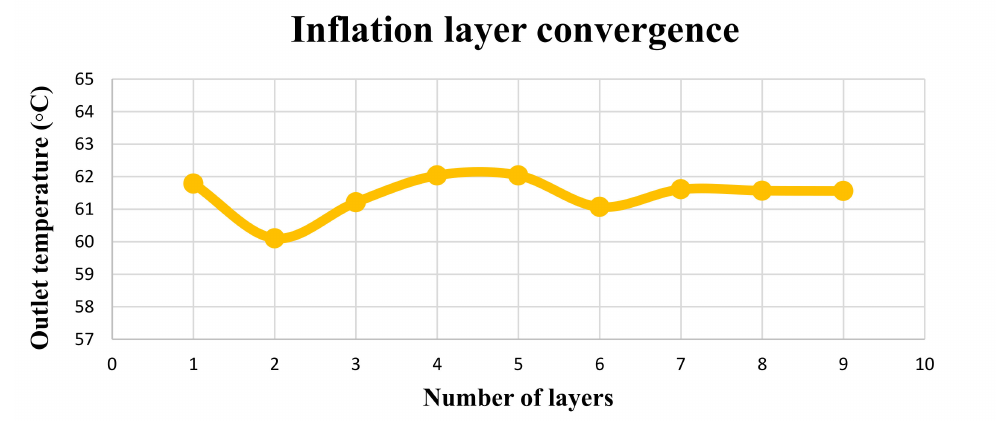
Figure 3. Inflation layer convergence study by varying number of layers from 1 to 9. Energies 2020 , 13 , x FOR PEER REVIEW